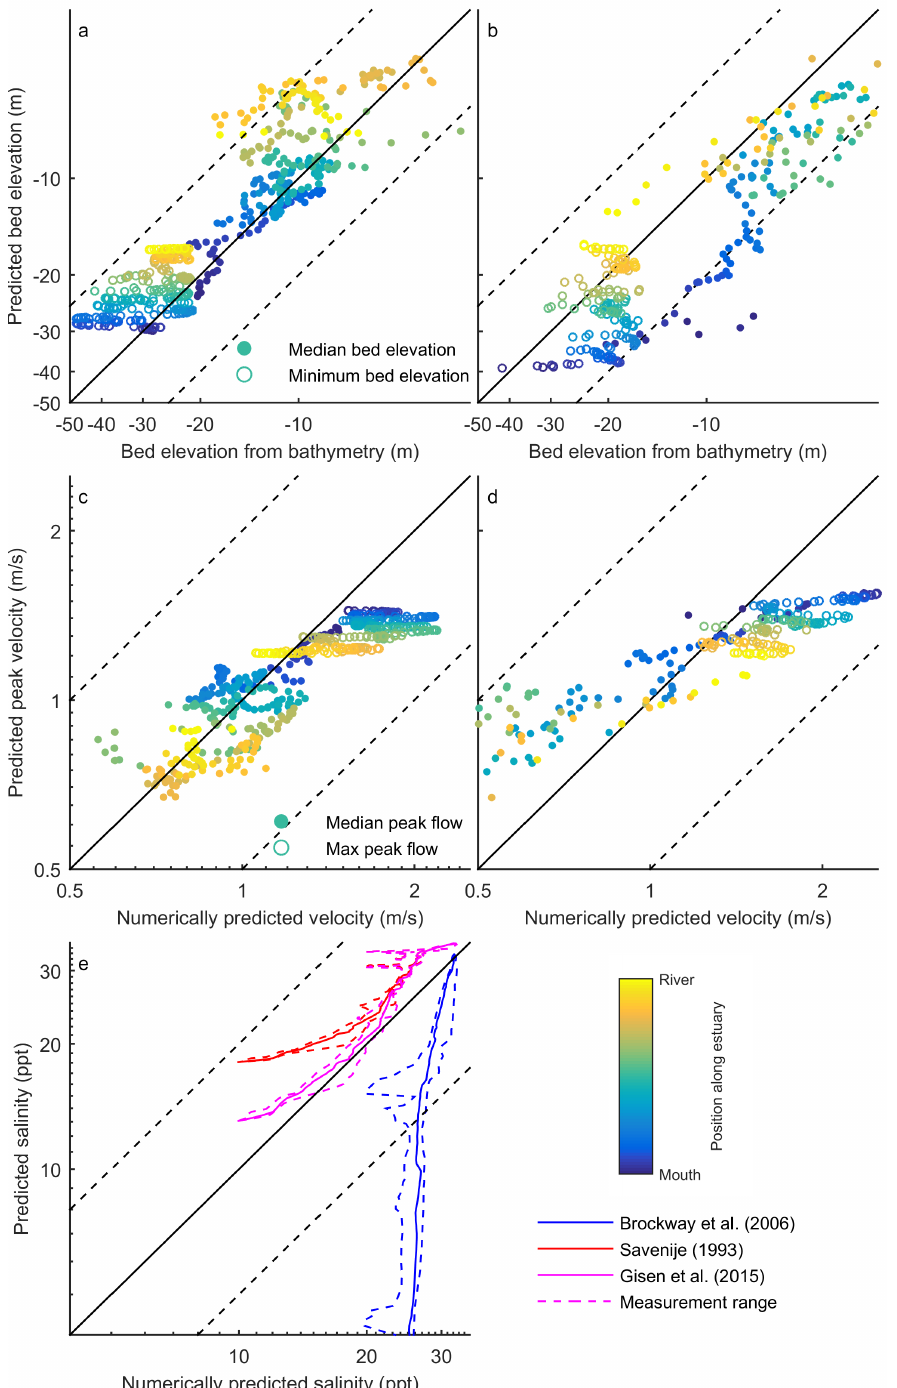
Figure 7. ( a , b ) predicted bed elevations against measured bed elevations taken from bathymetry for the Western Scheldt ( a ) and Columbia River ( b ); ( c , d ) predicted flow velocity from the tool against modelled flow velocity for numerical models of the Western Scheldt ( c ) and Columbia River ( d ). Filled circles indicate median values per cross-section, open circles indicate maximum values per cross-section. Dashed lines indicate a spread of a factor 2 around the x = y line. Colours indicate the position along the estuary, with blue being the mouth and yellow being the most landward location; ( e ) predicted salinity for the three predictors against measured salinity in the Western Scheldt. Solid lines indicate mean measured salinity per transect against predicted salinity and dashed lines indicate maximum and minimum measured